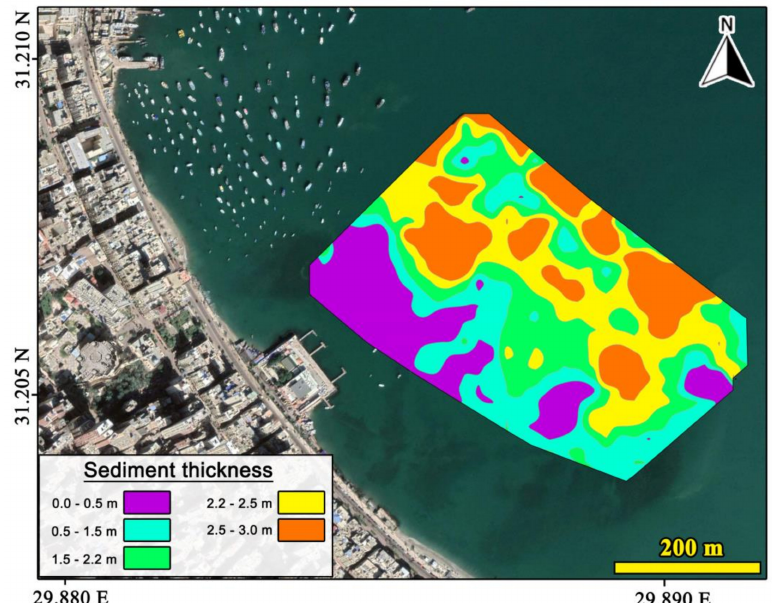
Figure 12. Isopach map for the sedimentation during the Roman period in the study area.